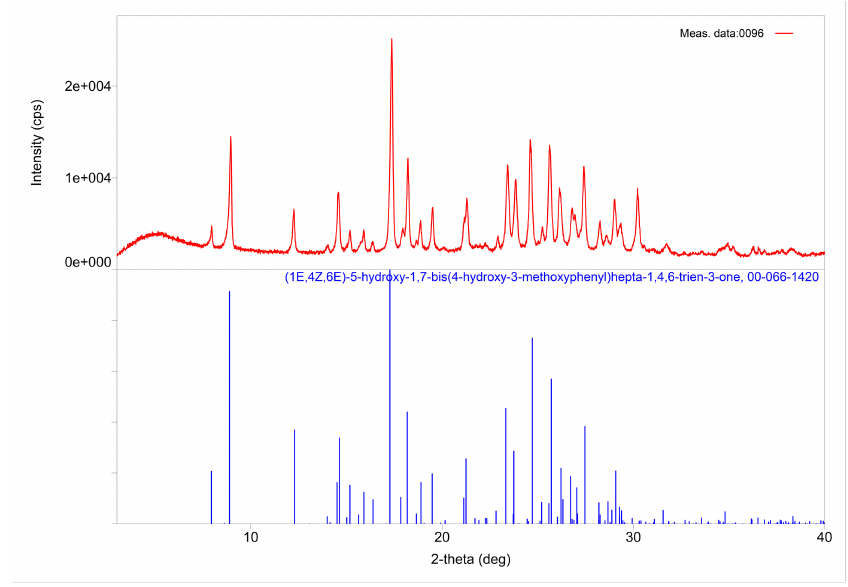
Figure S3: XRPD pattern for F_P80/SP_2:1. Reference XRPD pattern for curcumin (card number 00-066-1420; ICDD (PDF-2 Release 2016 RDB)) in blue is below the experimental pattern.